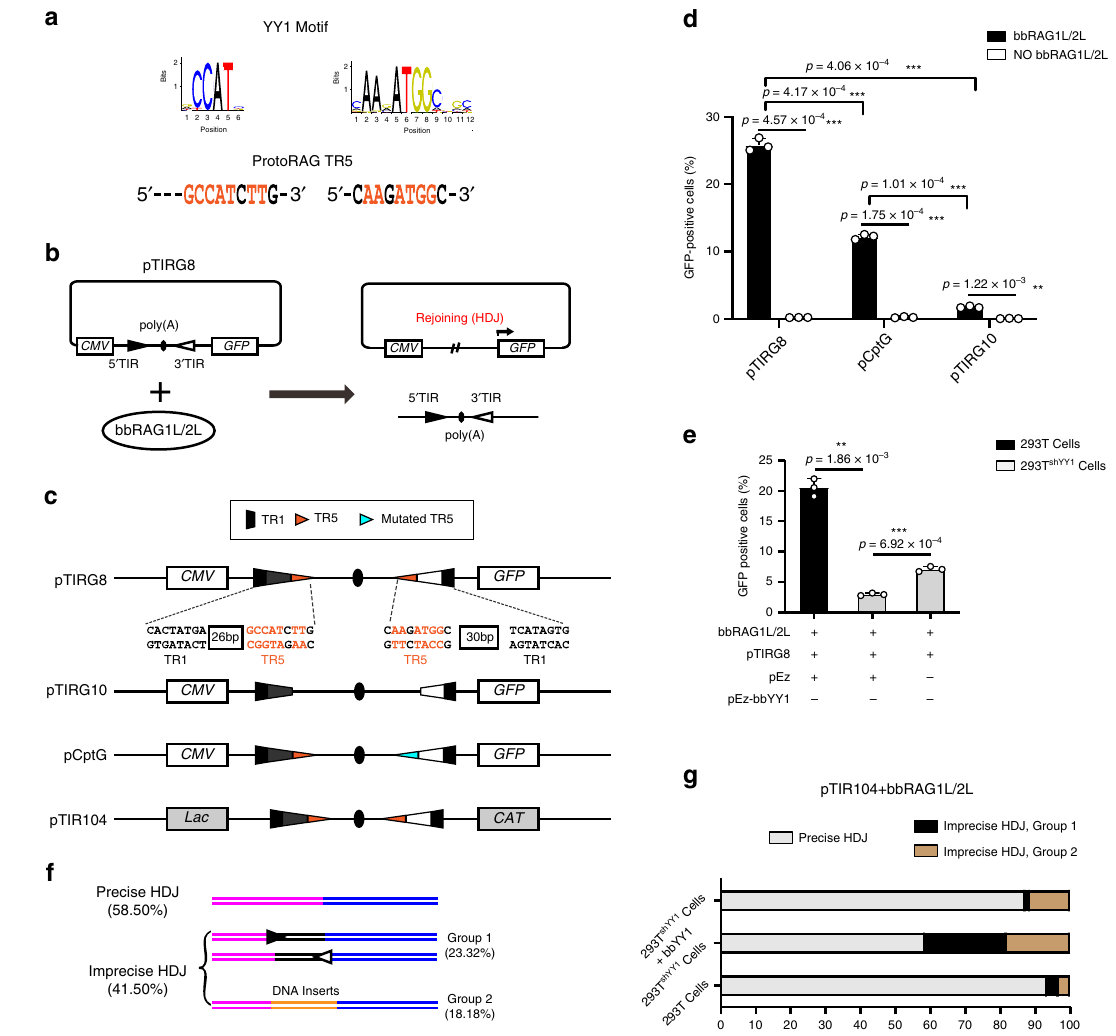
Fig. 3 BbYY1 effects on precise TIR-dependent DNA recombination mediated by bbRAG1L/2L ex vivo. a The TR5 element on ProtoRAG TIR is overlapped by a YY1-binding motif. The rainbow indicates the YY1-binding motif in the JASPAR database. Orange indicates critical base pairs in the YY1- binding motif. b Schematic diagram of the detection of TIR-dependent DNA recombination through FACS. Brie fl y, the pTIRG8 construct and indicated bbRAG1L/bbRAG2L expression vectors were co-transfected into 293T or 293T shYY1 cells. After recombination, the polyadenylation poly(A) terminal signal would be excised off and the green fl uorescent protein (GFP) would be expressed. The GFP signal could be detected by FACS. c Schematic diagram of TIR elements containing mutation plasmids pTIRG8, pTIRG10, pCptG, and pTIR104. The pTIRG8 and pTIR104 are WT TIR-containing constructs. The pTIRG10 is a substrate carrying deletion of both TR5 elements on TIRs. The pCptG is a construct with the mutated TR5 element on the 3 ′ TIR. CAT , chloramphenicol acetyltransferase gene; CMV, CMV promoter; Lac , Lac promoter. d Quanti fi cation of GFP-positive cells by fl ow cytometry showed that the TR5 element of ProtoRAG was important for effective TIR-dependent recombination ex vivo. pTIRG8, pTIRG10, and pCptG are as indicated in c . See also Supplementary Fig. 4A. e The fl ow cytometry assay showed that bbYY1 participated in TIR-dependent recombination. Quanti fi cation of GFP-positive cells by fl ow cytometry after transfection of pTIRG8 substrate and bbRAG1L/2L expression vectors into 293T cells (or 293T shYY1 cells) with or without bbYY1 expression constructs. See also Supplementary Fig. 4B. f Diagrammatic sketch of precise and imprecise HDJ products in 293T shYY1 cells. See also Supplementary Fig. 5A. g Percentage of precise and imprecise HDJ recombination in 293T and 293T shYY1 cells. The values of d and e are the means ± s.d. with n = 3 biologically independent experiments. A two-tailed, unpaired Student ’ s t test was used for the comparisons. * P < 0.05; ** P < 0.01; *** P < 0.001; **** P < 0.0001. ns, not signi fi cant. For d – g , source data are provided as Source Data fi pTIR104 together with the expression constructs of bbRAG1L and contained precise HDJs (Fig. 3f, g). As shown in Fig. 3f, precise bbRAG2L into 293T cells. Then, the recombined pTIR104 was HDJs indicated that both the 5 ′ TIR and 3 ′ TIR were completely recovered and transformed into E. coli. DH5 α . After growing on the excised from the pTIR104 construct. Imprecise HDJs were de fi ned chloramphenicol-containing culture dish, a total of 153 or 253 as HDJ products containing partial TIRs on the pTIR104 construct random HDJ-containing plasmids from 293T WT or 293T shYY1 (group 1) and products with DNA inserts or DNA self- cells after transposon excision were recovered and sequenced, transposition after host DNA rejoining (group 2; also shown in respectively. The sequencing results showed that 93.46% of the Supplementary Fig. 5A). As shown in Fig. 3g, when bbYY1 was clones recovered from WT 293T cells contained precise HDJs. overexpressed in 293T shYY1 cells, the ratio of precision HDJs was increased from 58.50% to 87.34%. Notably, the imprecise HDJs with However, only 58.50% of clones recovered from 293T shYY1 cells